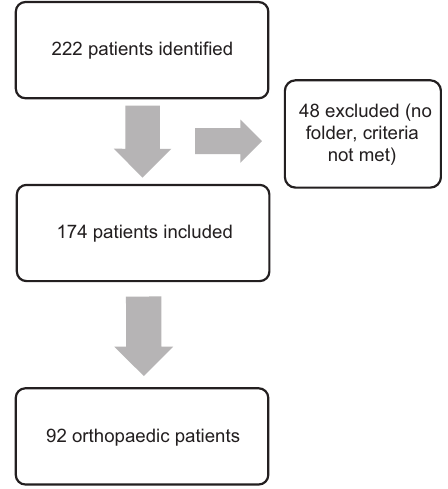
Figure 1. Patients included in the study. Two-hundred and twenty- two patients initially identi fi ed, 48 excluded; a total of 174 patients were included in the study and 92 of these were referred to the orthopaedic unit. Table 1. Orthopaedic operations and